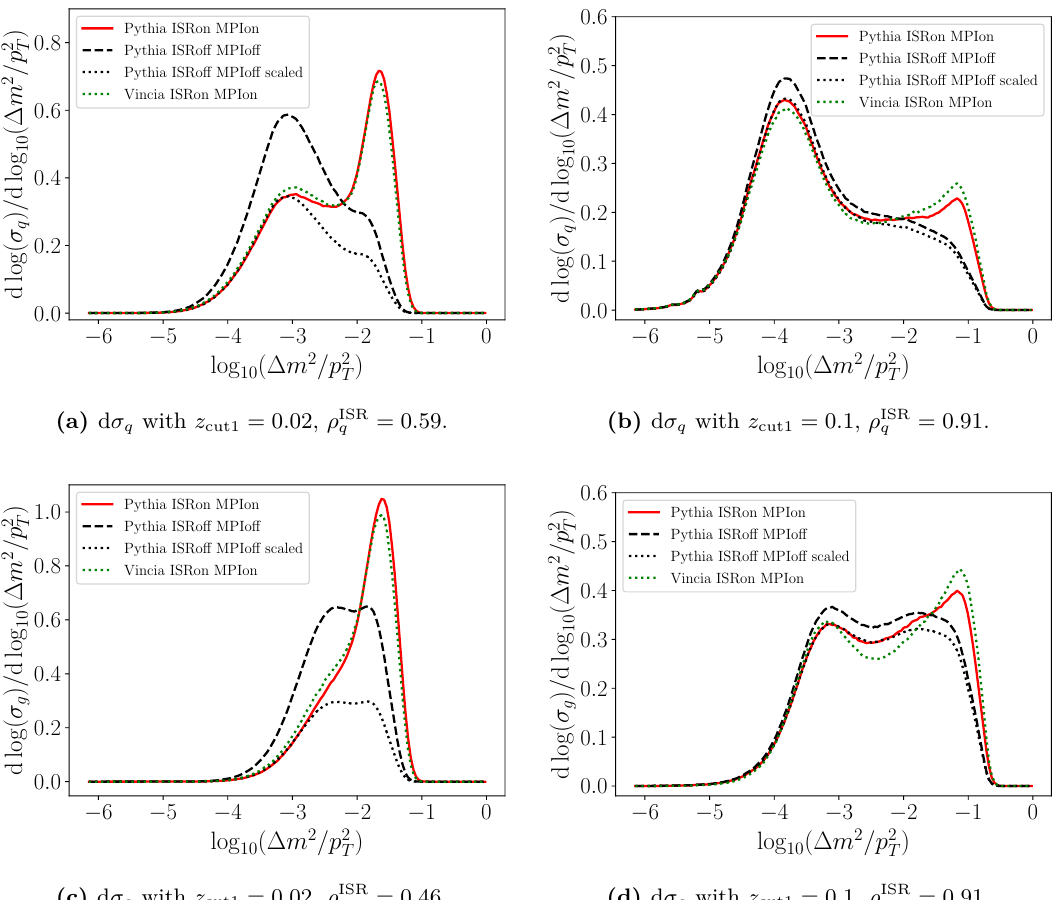
Figure 10. Monte Carlo results of the differential jet mass cross sections of quark jet (top row) and gluon jet (bottom row) in collinear drop with β 1 = β 2 = 0 , z cut1 = 0 . 02 , z cut2 = 0 . 08 (left) and z cut1 = 0 . 1 , z cut2 = 0 . 4 (right). The red solid and green dotted lines are results obtained by Pythia and Vincia generators respectively, with the ISR and MPI effects included. The black dashed line labels the Pythia result without the ISR and MPI effects included and the black dotted line indicates the same results but multiplied by a scaling factor. These phenomenological factors are 0.59, 0.91, 0.46 and 0.91 for the four cases